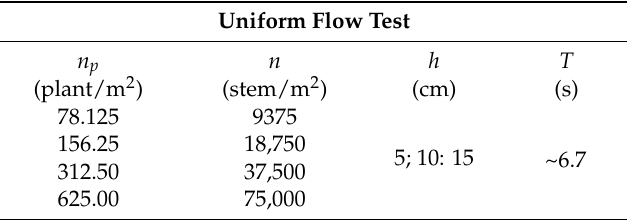
Figure 4. Plants distribution for the uniform flow tests: ( a ) plants density n p = 78.125 plant/m 2 ; ( b ) plants density n p = 156.25 plant/m 2 ; ( c ) plants density n p = 312.5 plant/m 2 ; and ( d ) plants density n p = 625 plant/m 2 . Table 2. Summary of the tests in uniform flow